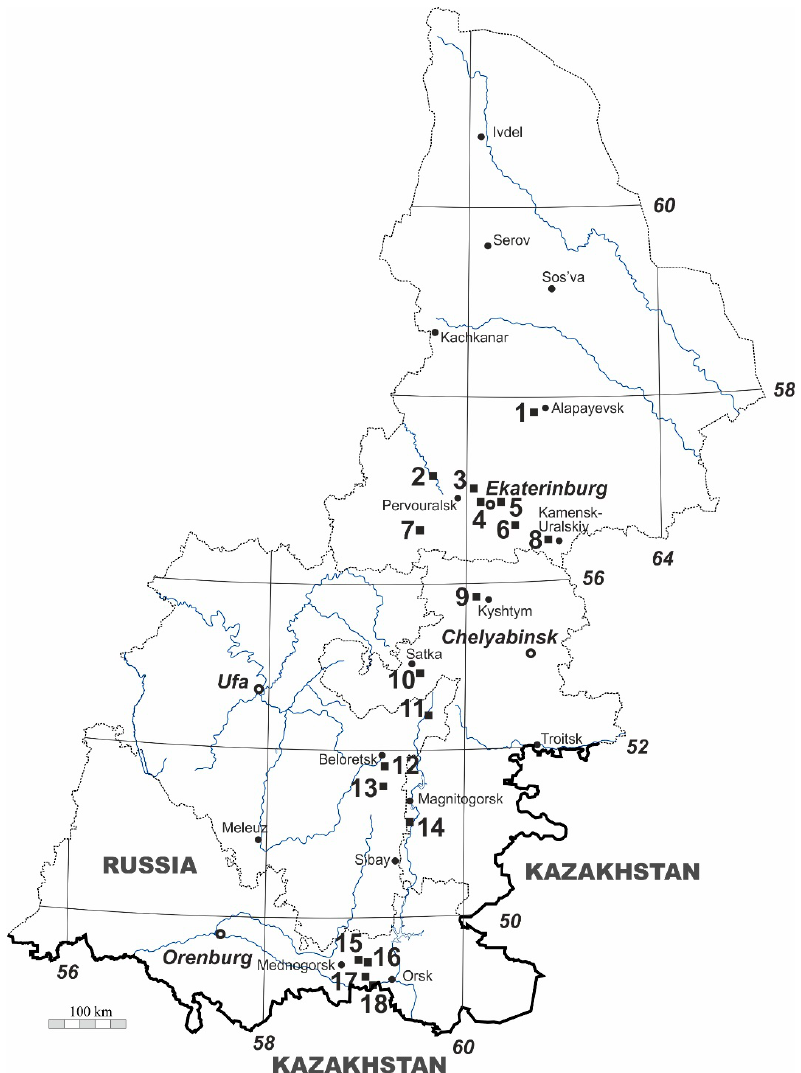
Figure 1. Study area and sampling localities. Modified from maps at d-maps.com. Table 1. Coordinates, elevation and rock types in the study